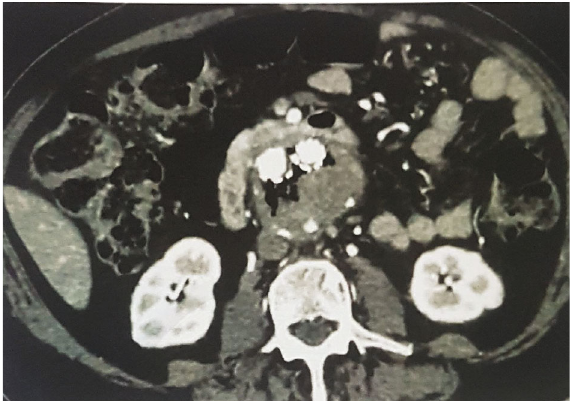
Figure 1: Perigraft gas loculi on